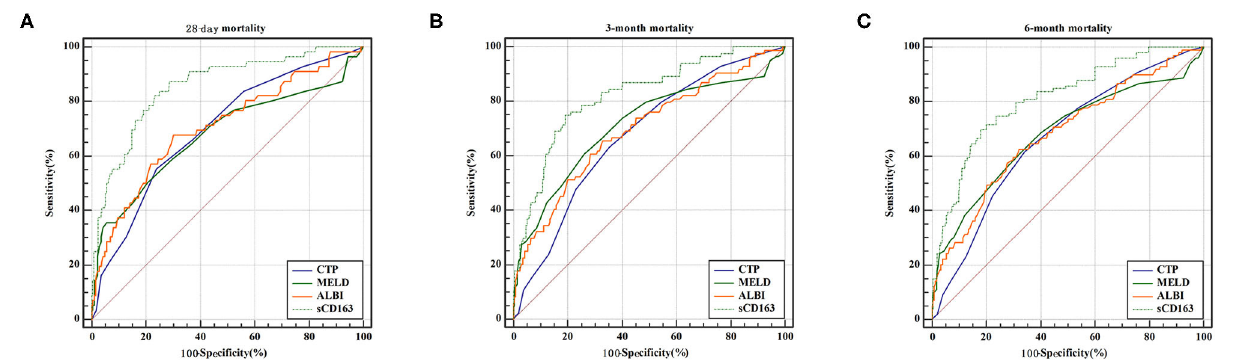
FIGURE 2 | ROC curve analysis and comparison between sCD163 and prognostic scores for predicting 28-day, 3-month and 6-month mortality (A) ROC for 28-day; (B) ROC for 3-month; (C) ROC for 6-month.